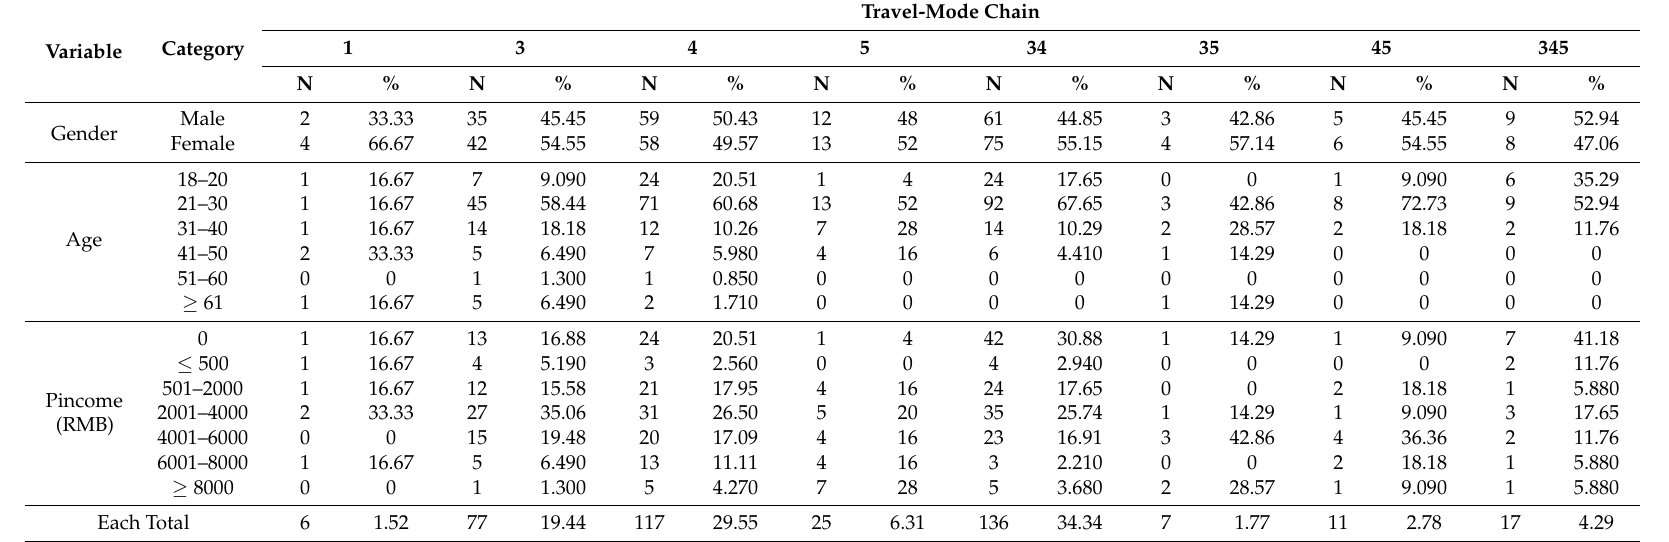
Table 5. Frequency distribution of socio-demographic characteristics over different travel-mode chains.